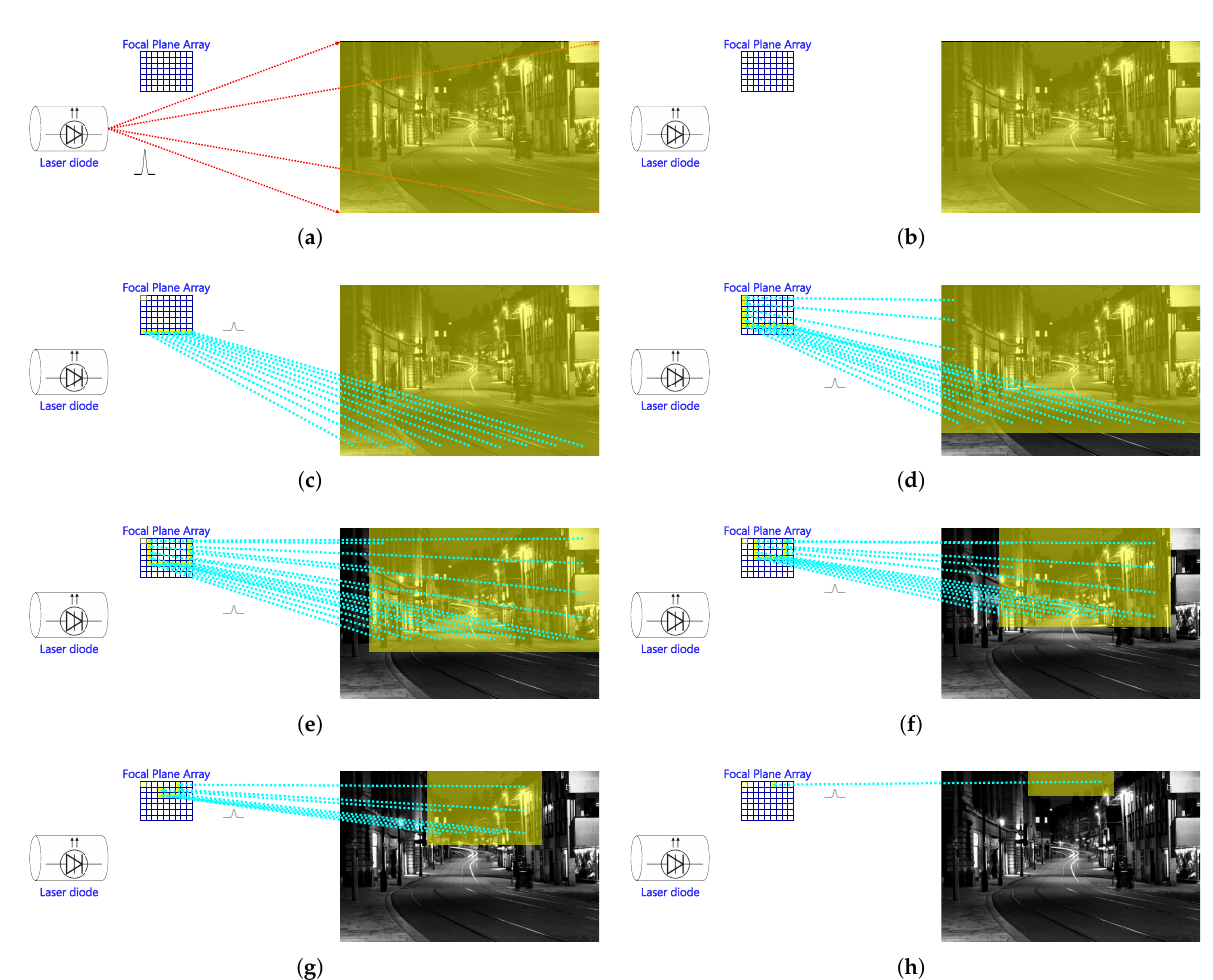
Figure 4. Operating strategy of the flash LIDAR system ASC Peregrine. ( a ) The LIDAR fires a flash pulse of the laser at the target; ( b ) the LIDAR waits for the reflection of the laser; ( c ) after reception, the LIDAR calculates the target distance with the ToF in each APD; ( d – h ) the LIDAR repeats ( c ) the sequence for all other APDs. After all is finished, the LIDAR restarts from ( a